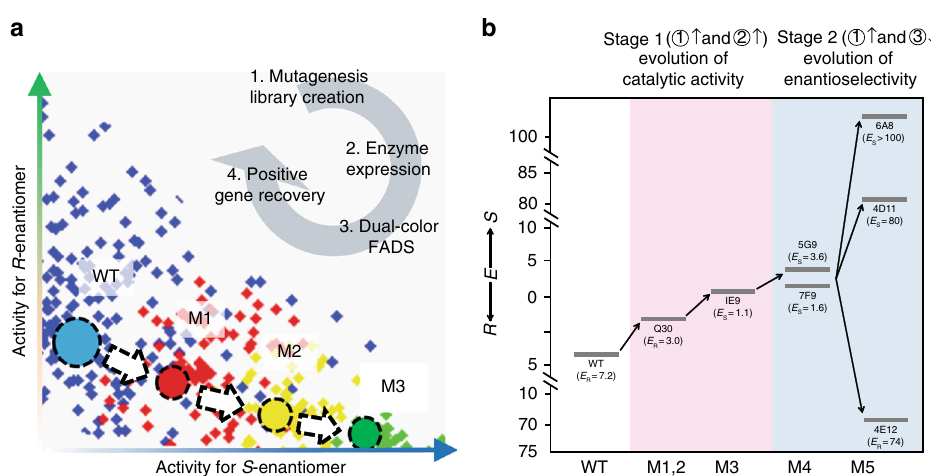
Fig. 2 Directed evolution of the enantioselectivity of AFEST. a Conceptual progression of enzymatic enantioselectivity enhancement by iterative rounds of mutagenesis and use of the DMDS process. b Cumulative improvement in the enantioselectivity of AFEST resulting from the various directed evolution steps of the present